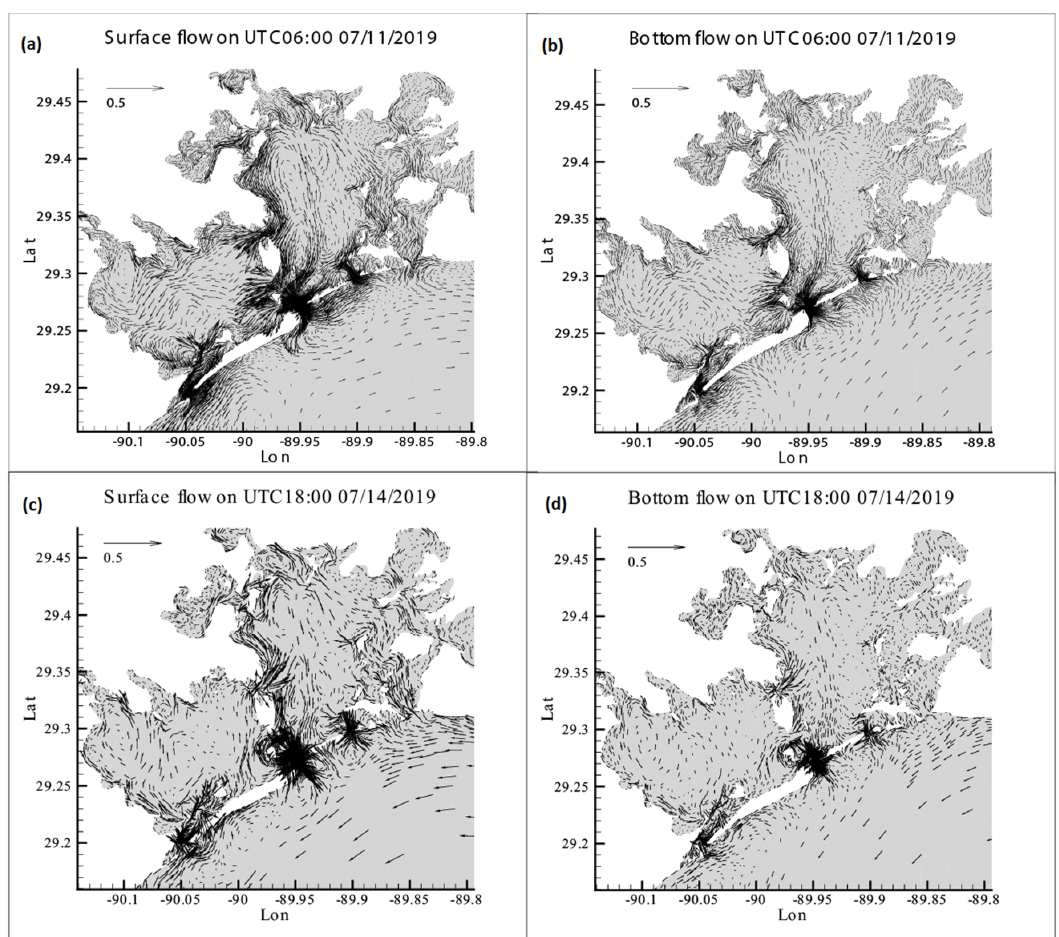
Figure 7. Surface and bottom flows under Hurricane Barry in 2019. ( a , b ) are surface and bottom flows on 0600 UTC, 11 July 2019; ( c , d ) are surface and bottom flows on 1800 UTC, 14 July